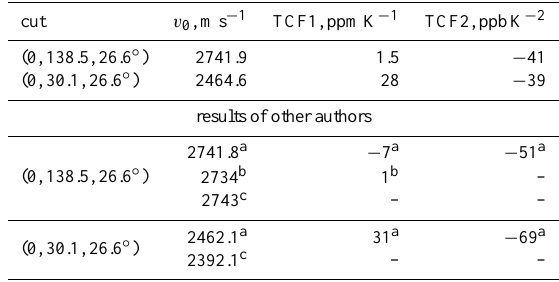
Table 1. Comparison of our measurement results with literature data. In case of (Kosinski et al., 2001), the values are calculated using tensor data.